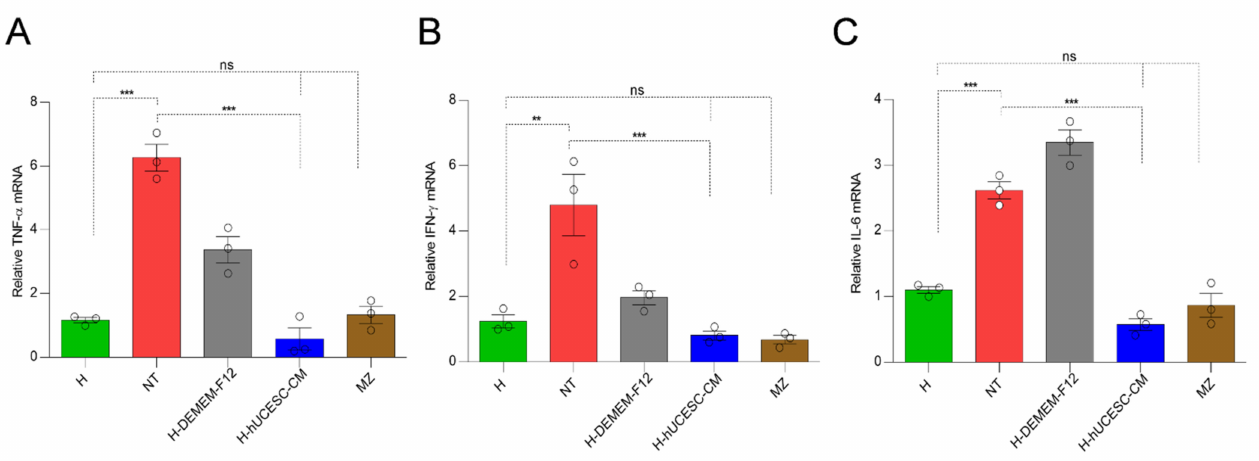
Figure 7. Real-time PCR of pro-inflammatory cytokines in colon samples. ( A ) Tumor necrosis factor-alpha (TNF- α ), ( B ) Interferon-gamma (IFN- γ ), and ( C ) Interleukin-6 (IL-6) mRNA expression levels in colon of mice. Data are expressed as mean ± SEM. ns = not significant. ** = p < 0.01; *** = p <